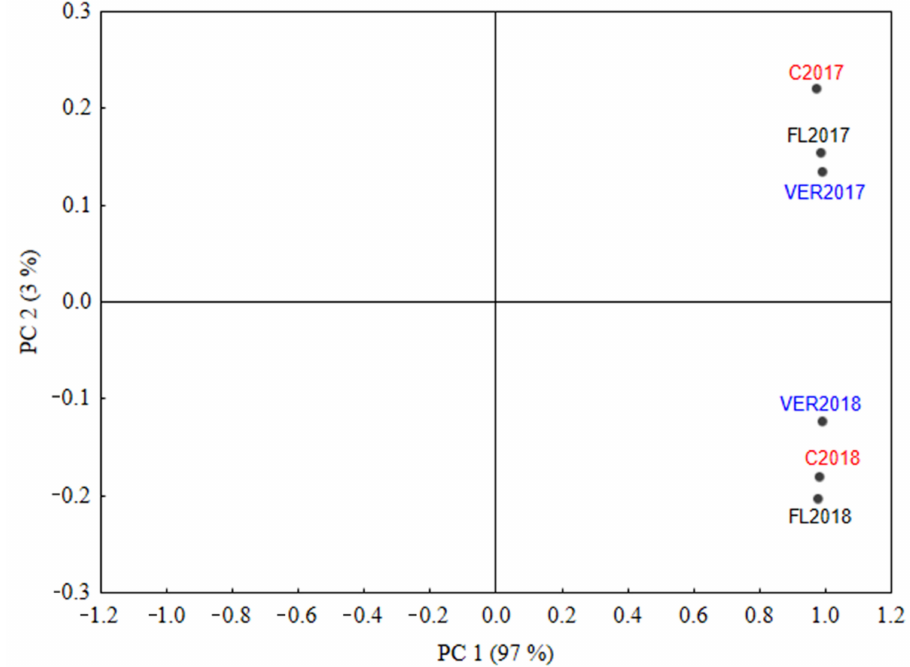
Figure 1. Two dimensional principal component analysis plot for the volatile compound concentra- tions in Babica wine made from control and two defoliation treatments in 2017 and 2018; distribution of the treatment year variable (C = control; FL = removal of six leaves before flowering; VER = removal of six leaves at the end of